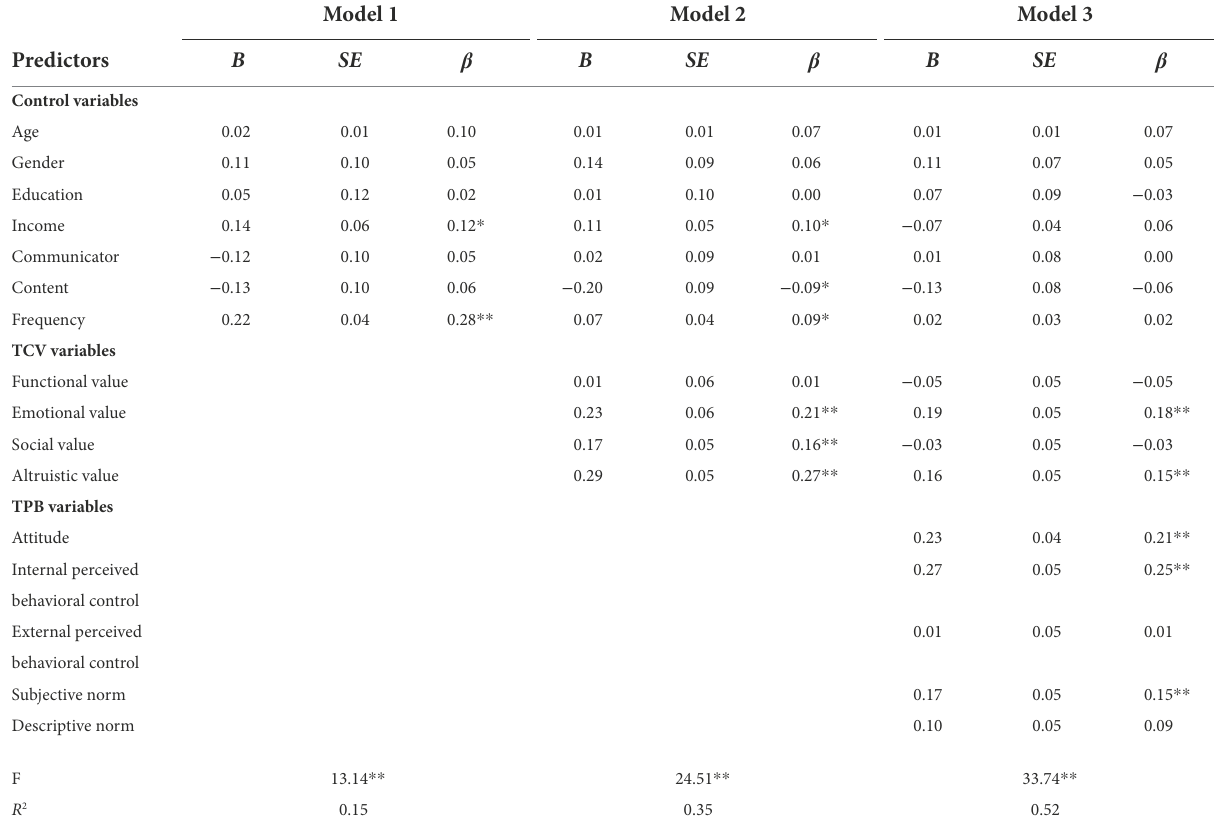
TABLE 3 Regression